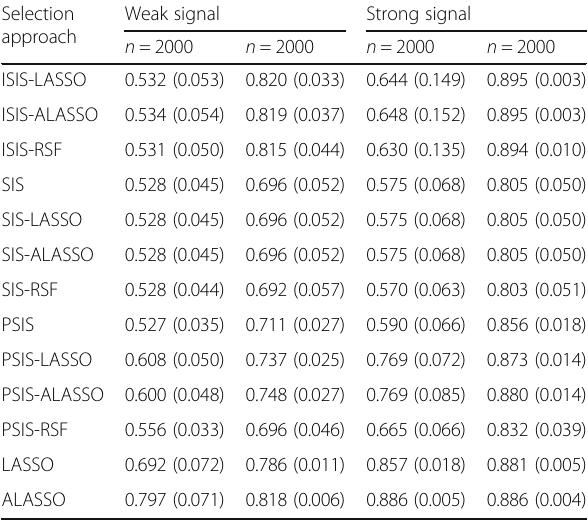
Real-data example The variable selection methods (SIS, PSIS, LASSO, LASSO, RSF) and the nine combinations were used to identify SNPs that predict overall survival in men with metastatic prostate cancer who participated in a phase III clinical trial (CALGB 90401). Overall survival was de- fined as the date of death from date of random assign- ment. We confined our analysis to 623 genetically defined Caucasians men who participated in the GWAS Table 6 Mean (SD) of calibration slope for testing set over 300 simulations Selection